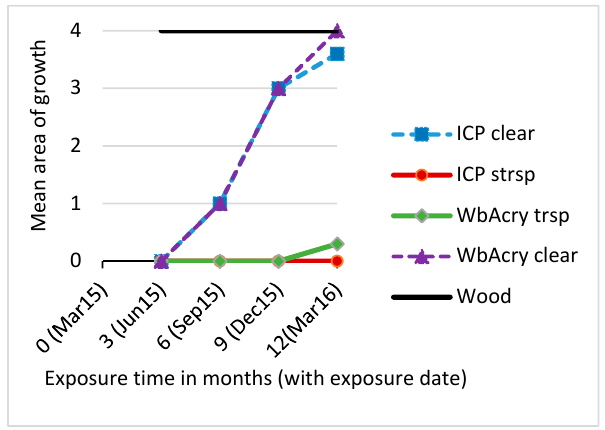
Figure 2. Mean area of fungal growth (EN 16 492) on panels versus exposure time.